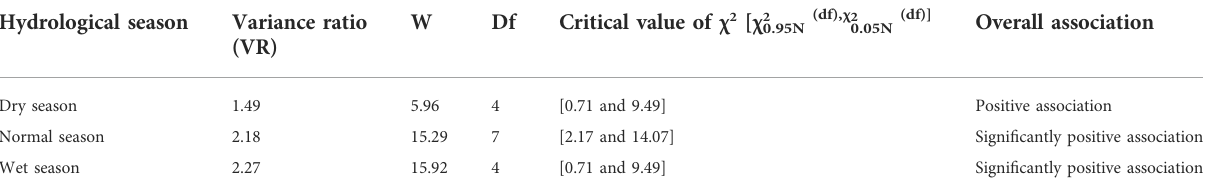
TABLE 4 Overall association of the dominant phytoplankton species in different hydrological seasons. Hydrological season